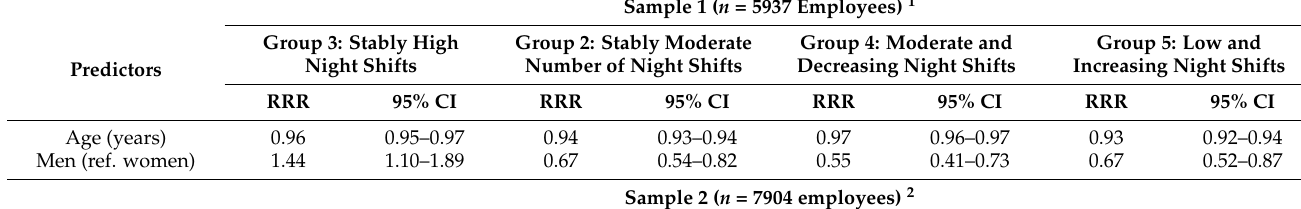
Table 3. The goodness of fit of group-based trajectory analysis sample 3.